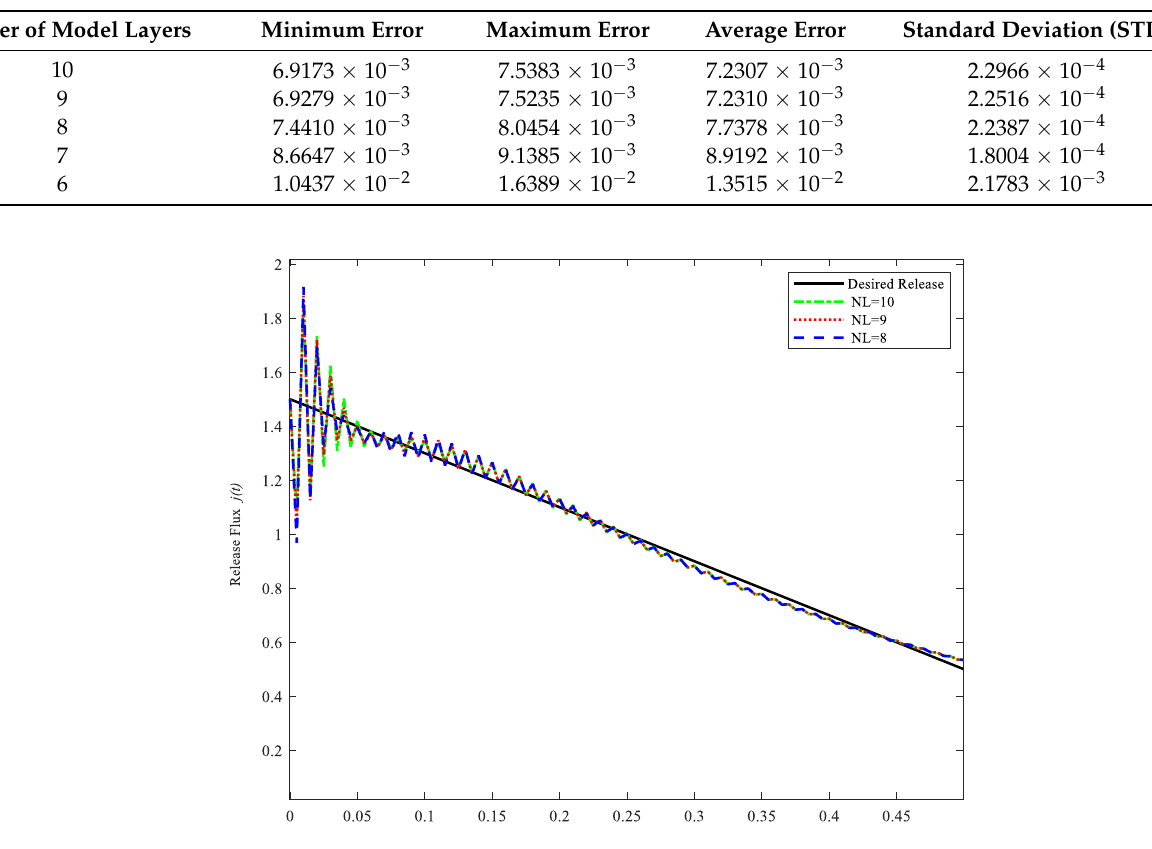
Table 3. Statistical analysis of the error for optimization of the initial drug concentration (Case 2). Number of